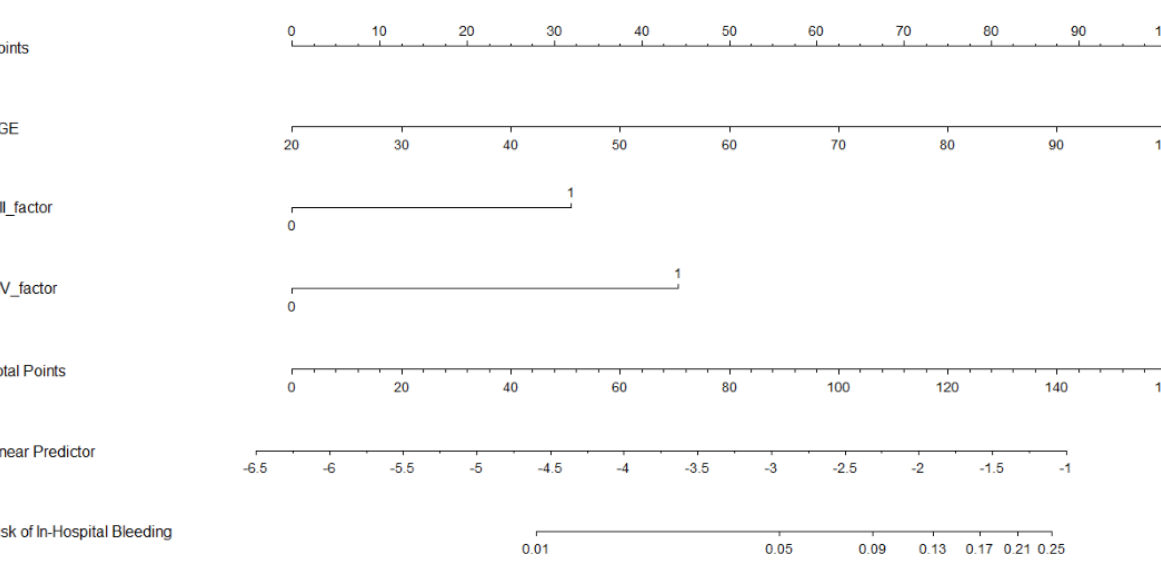
Figure 3. Nomogram for predicting in-hospital bleeding in patients with acute ST-segment elevation myocardial infarction. AGE: age (years); KIII-factor: Killip III; KIV-factor: Killip